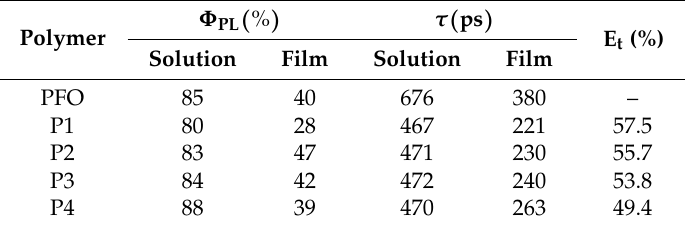
Table 2. The quantum yields, PL decay lifetime and energy transfer efficiency of polymers.